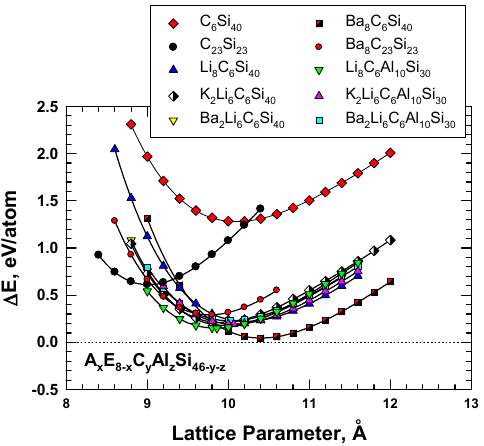
Figure 4. Computed energy change curves for various C-substituted Type I silicon clathrate frameworks with and without Li, Na, K, and Ba guest atoms. From Chan et al. [8]. Reprinted with permission from Springer.